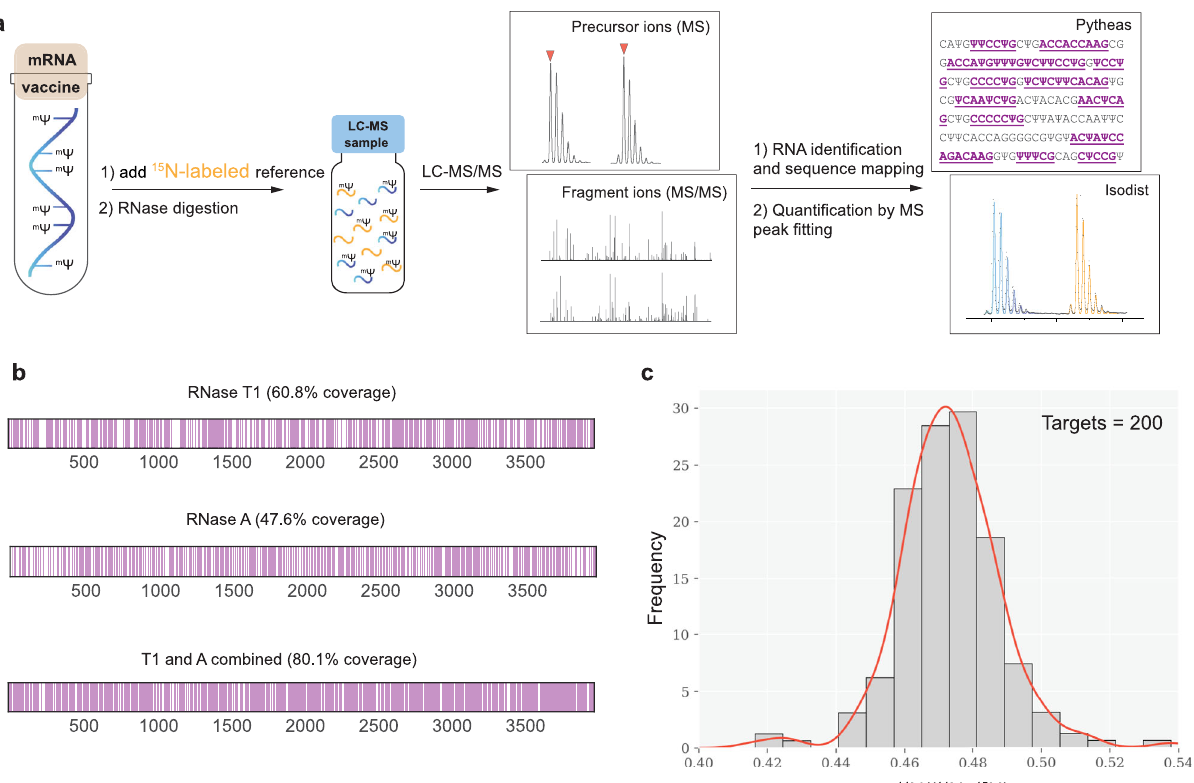
Fig. 4 Sequence coverage and relative quanti fi cation of COVID-19 mRNA vaccine mimic. a mRNA analysis fl owchart. b Nucleolytic fragments found by the Pytheas search in the RNase T1 or A treated mRNA sample are mapped on to the full-length sequence. Pink bars are used to indicate nucleoside positions identi fi ed and coverage is reported as a percent of the total (3995 nt) present. Combined coverage was determined by merging sequence IDs from T1 and A datasets. Results for the sample containing a mixture of 14 N- and 15 N-labeled mRNAs are shown. c Histogram plot of 14 N/( 14 N + 15 N) isotope ratios for a total of 200 nucleolytic fragments identi fi ed and quanti fi ed in the RNase T1 and A datasets (source data are provided as a Source Data fi le). The mean = 0.47 and the SD = 0.01 were obtained by fi tting the values to a Gaussian